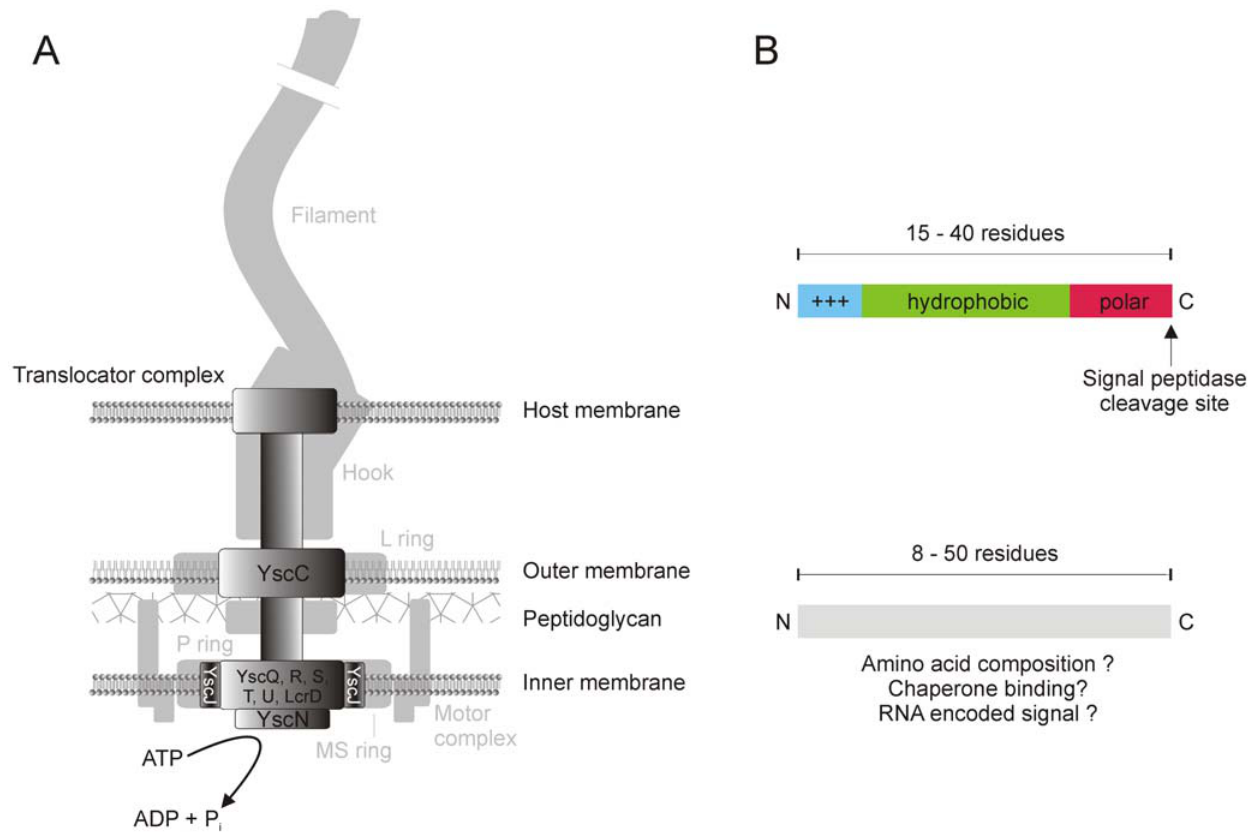
Figure 1. The bacterial type III secretion system (T3SS) forms a translocator complex spanning the bacterial and the host cell membranes for protein translocation. (a) Schematic T3SS structure together with a flagella apparatus (shaded in light grey). The nine components being conserved among T3SS are named in Yersinia nomenclature. In flagella apparati, proteins of the axial structure are exported via a T3SS, e.g. flagellins. Note that T3SS injection needle and translocator complex are not present in flagella (adapted from Sheng et al. [5] and Pallen and Matzke [4]). (b) Comparison of the features of classic signal peptides (top) [12] and the proposed features of T3SS signals (bottom). Both kinds of signals are located at the N-terminal end of a